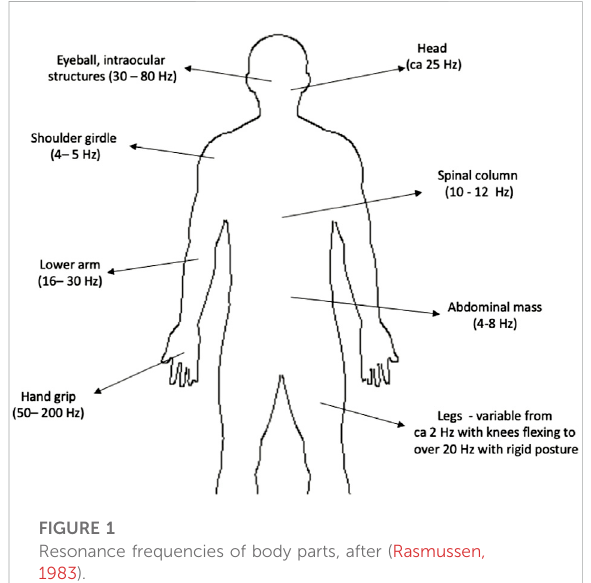
FIGURE 1 Resonance frequencies of body parts, after (Rasmussen,